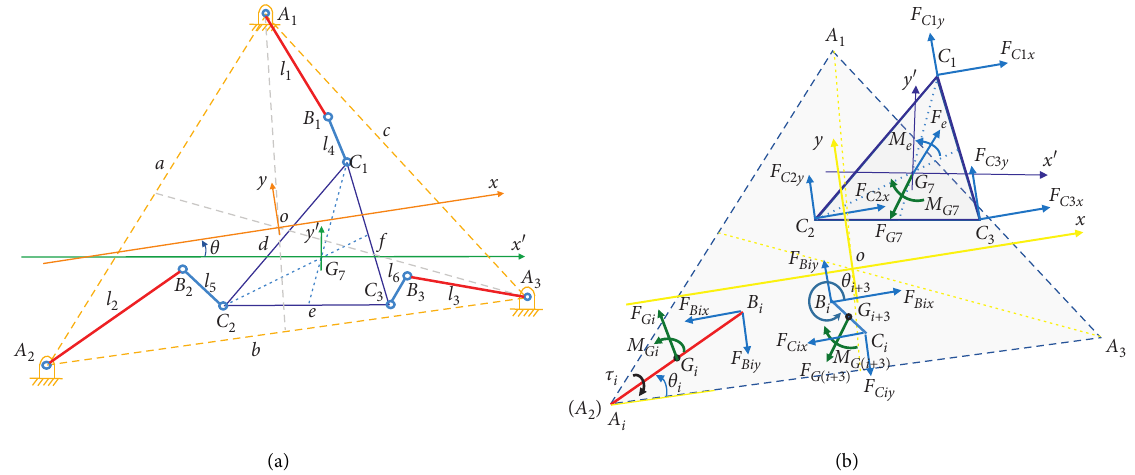
Figure 1: Schematic diagram of the 3-RRR PPM and dynamics modeling. (a) Schematic diagram of the 3-RRR PPM. (b) Process of the dynamics